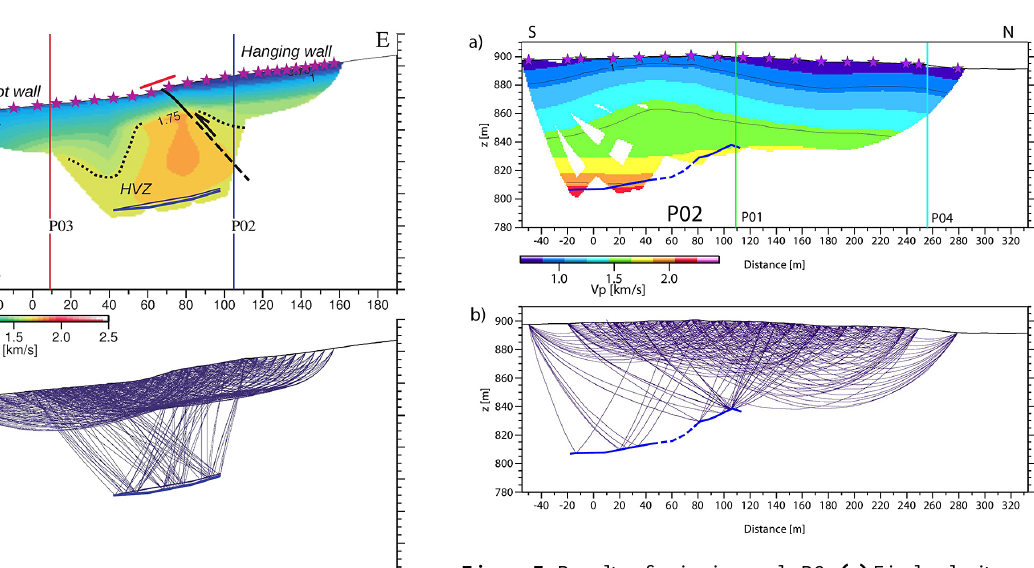
Figure 7. Results of seismic profile P2. (a) Final velocity model including the inverted reflector (blue line). The segmented blue line indicates the regions where the reflector is poorly constrained. Stars represent shot positions. Zero distance represents position of the first geophone along the profile. The intersections between P2 with profiles P1 and P4 are also indicated (see Fig. 2). (b) Associated ray